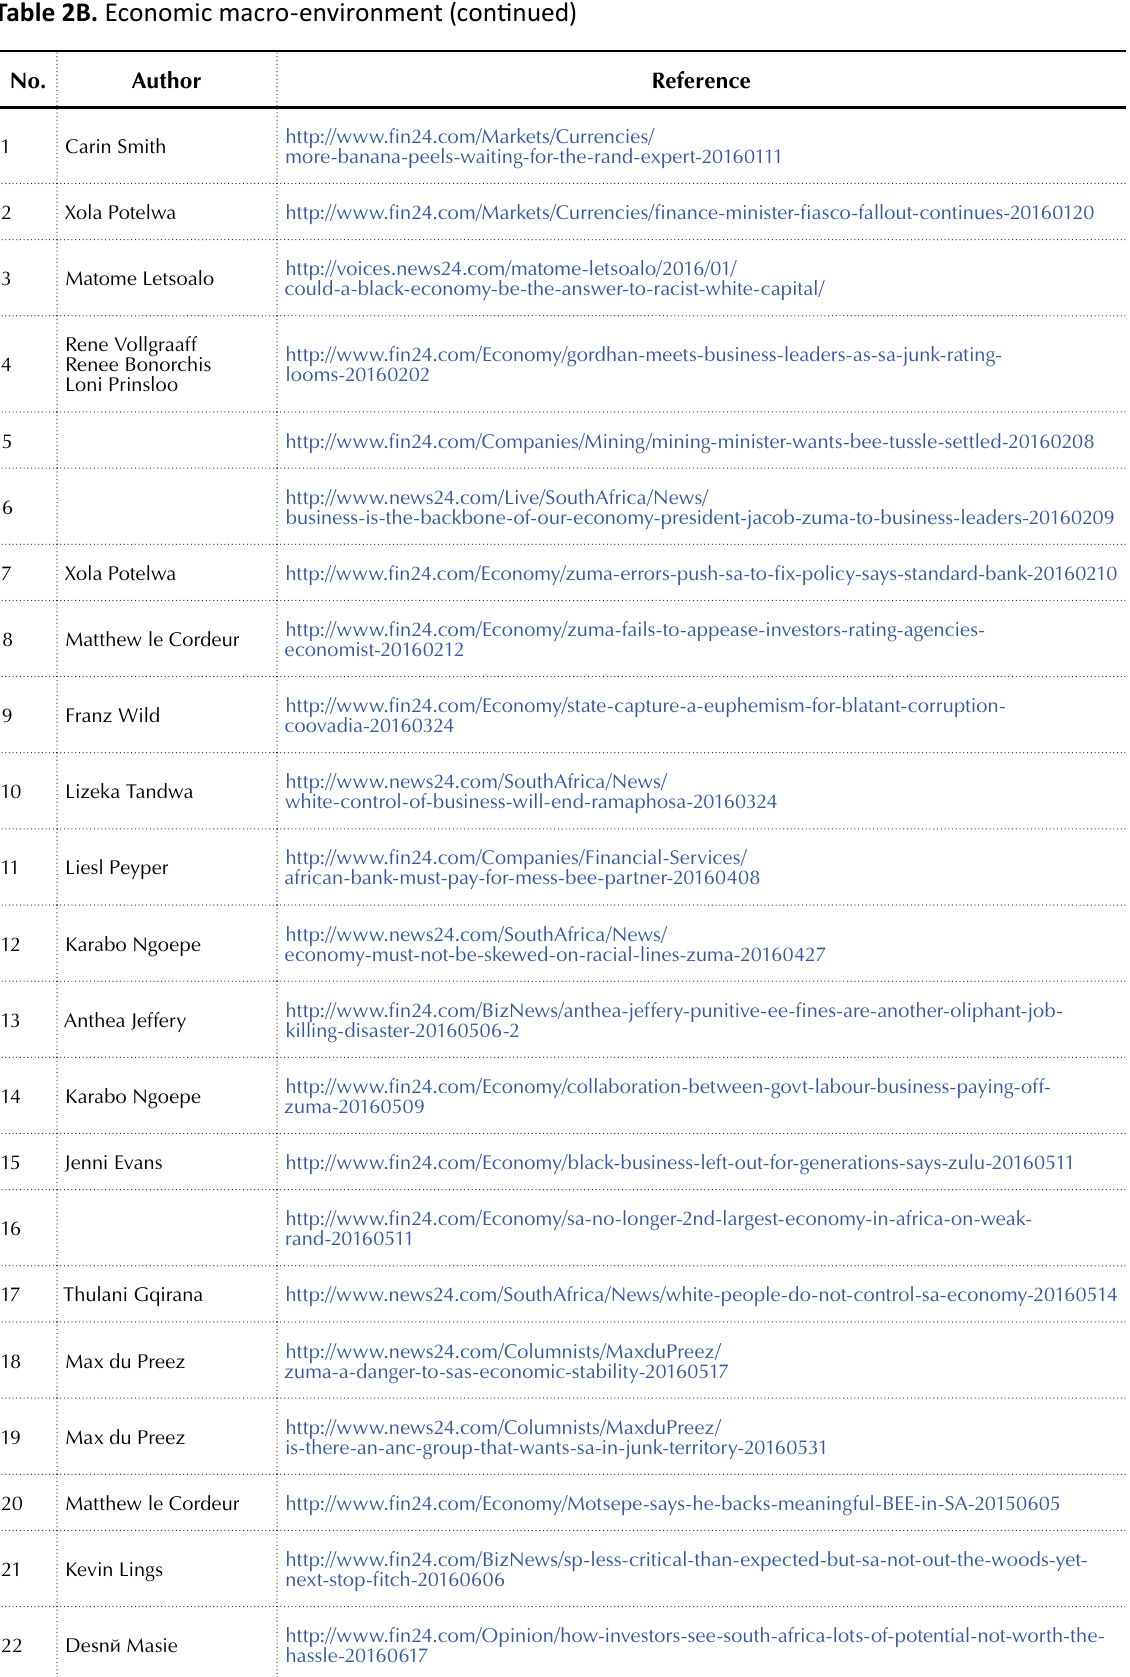
Table 2B. Economic macro-environment